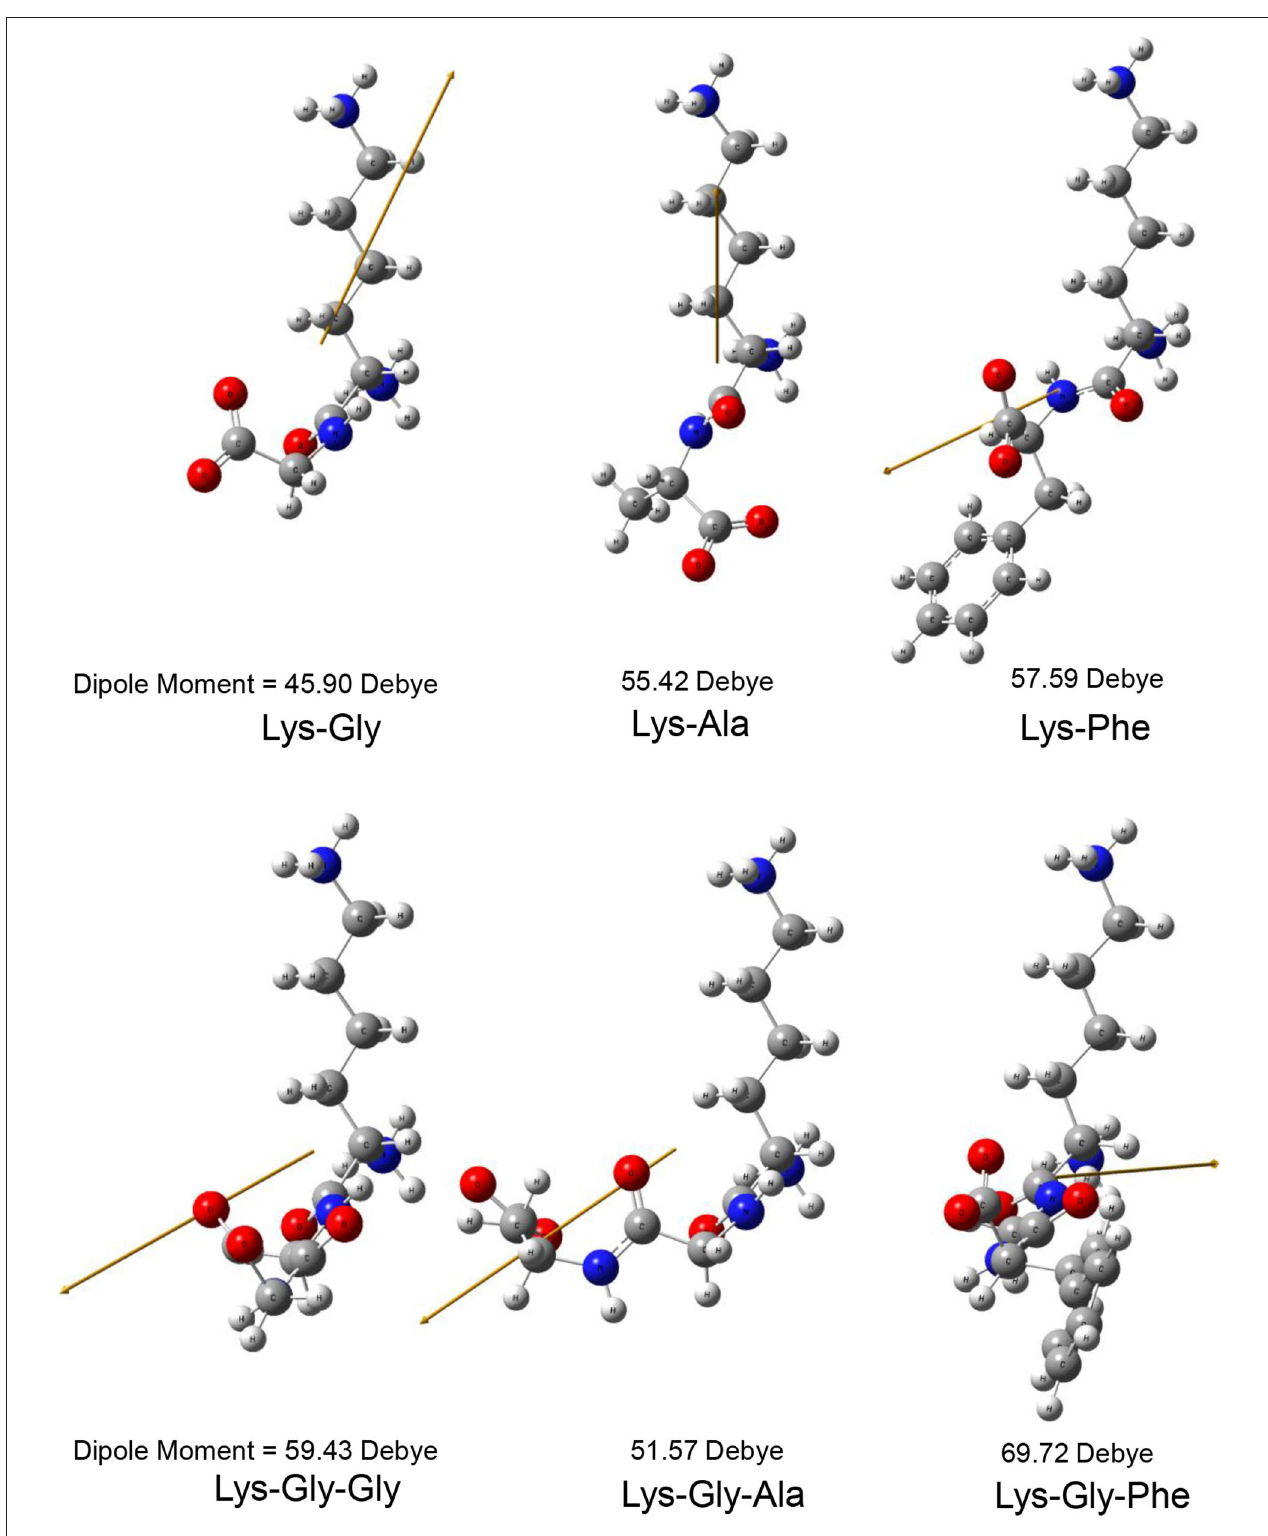
FIGURE 2 | Steric structure of peptides and their dipole moments (the yellow arrow represents the dipole derivative unit vector).